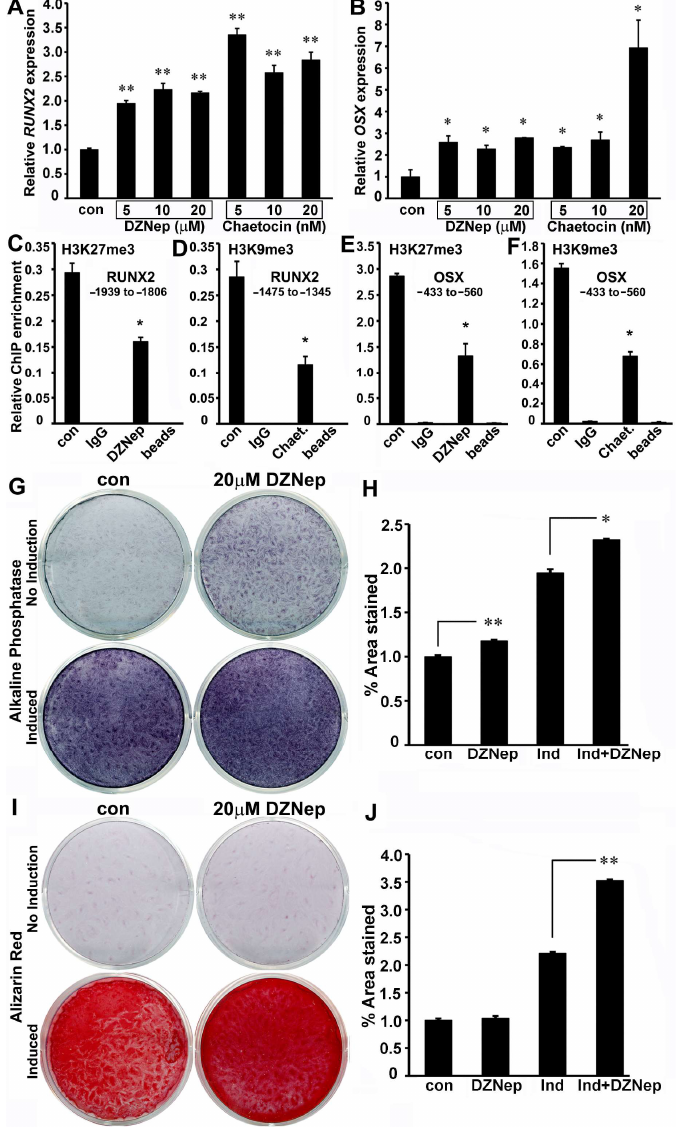
Figure 4. Epigenetic reactivation of RUNX2 and OSX gene expression led to increased mineralization in PDL progenitors. ( A , B ) PDL cells were treated with inhibitors against H3K27me3 (DZNep) and H3K9me3 (Chaetocin) for 48 h, and transcript levels of RUNX2 ( A ) and OSX ( B ) were analyzed by RT-PCR. Transcript levels for both genes were upregulated upon inhibitor treatment in PDL cells, with Chaetocin treatment leading to higher expression levels. ( C–F ) ChIP analysis in DZNep and Chaetocin-treated PDL cells for H3K27me3 and H3K9me3 enrichment on ( C , D ) RUNX2 and ( E , F ) OSX promoters, respectively. Untreated cells were used as controls, and beads-alone immunoprecipitations were used to determine ChIP specificity and background. Promoter regions analyzed are indicated for respective enrichment plots. RT-qPCR data and ChIP experiments are representative of independent experiments with similar results (n = 4–6 for RT-PCR assays; n = 4–5 for ChIP assays). ( G ) Alkaline phosphatase activity in PDL progenitors treated with 20 µ M DZNep for 7days with or without osteogenic induction. Untreated cells served as controls. ( H ) Representative quantitation of ALP activity after DZNep treatment in PDL cells. ( I ) Alizarin Red assay for calcium deposition in PDL cells treated with DZNep as in ( G ) after 21 days of culture. ( J ) Representative quantitation of Alizarin Red staining intensity after DZNep treatment in PDL cells. All data are presented as mean ± SD. (* p < 0.05, ** p < 0.01). µ M, micromolar; nM,